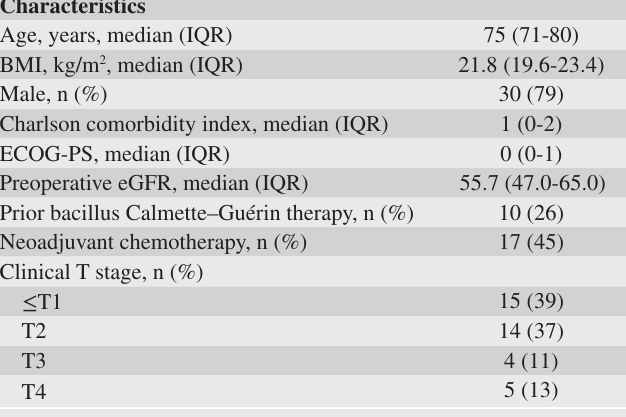
Table 1. Characteristics of the Study Population (N =